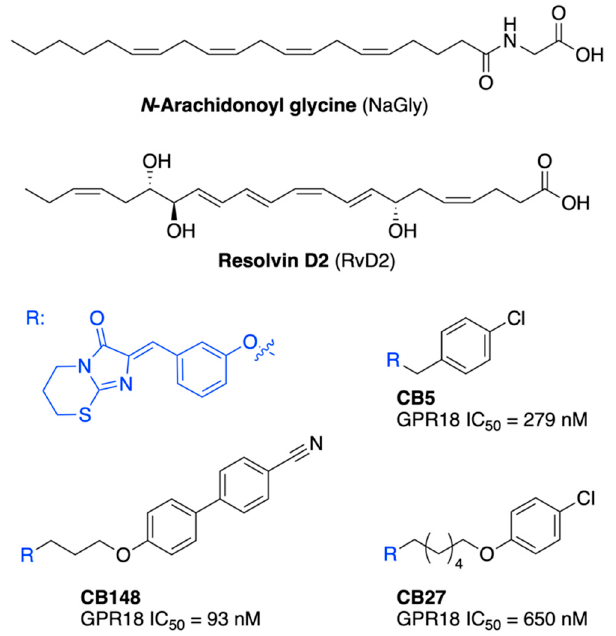
Figure 1. Structures of known GPR18 receptor agonists NaGly and RvD2, as well as known antag- onists from our group (CB ligands).